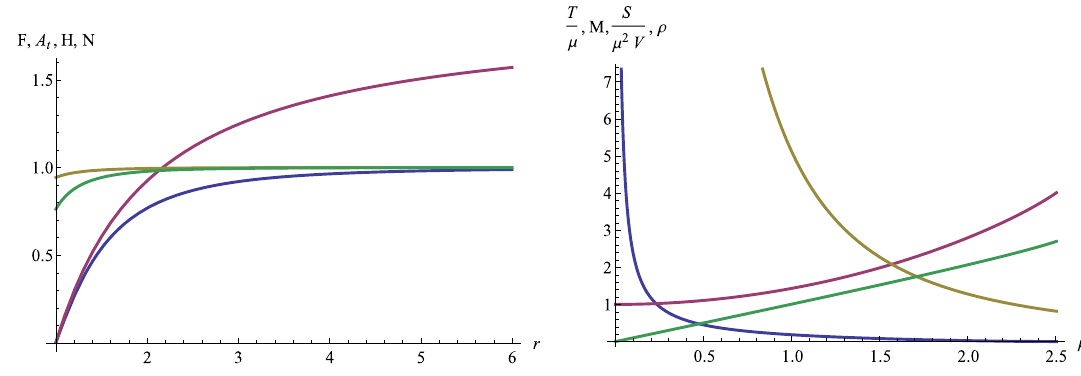
Figure 1 . Left: radial pro(cid:12)les for the (cid:12)elds F (Blue), A t (Purple), H (Yellow) and N (Green) for (cid:22) = 1 : 8. Right: termperature T (Blue), black hole mass M (Purple), black hole entropy S (Yellow) and charge density (cid:26) (Green) for the dual (cid:12)eld theory as a function of the chemical potential (cid:22) . while near the boundary (UV) we